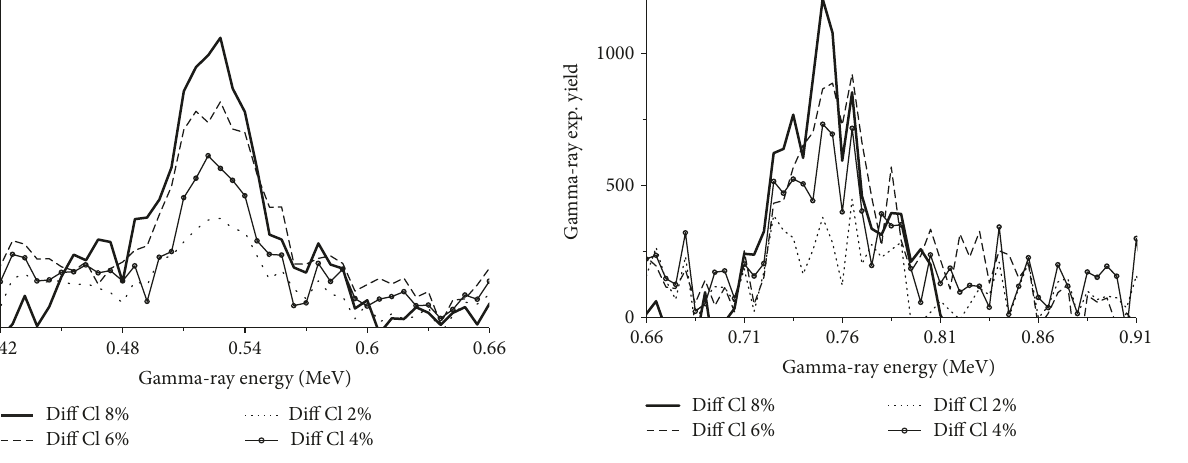
Figure 10: Pulse height di ff erence spectra of the CeBr for 517keV chlorine gamma rays from 2%, 4%, 6%, and 8% chlorine-contaminated water samples over 0.42 – 0.66 MeV range superimposed upon each other.